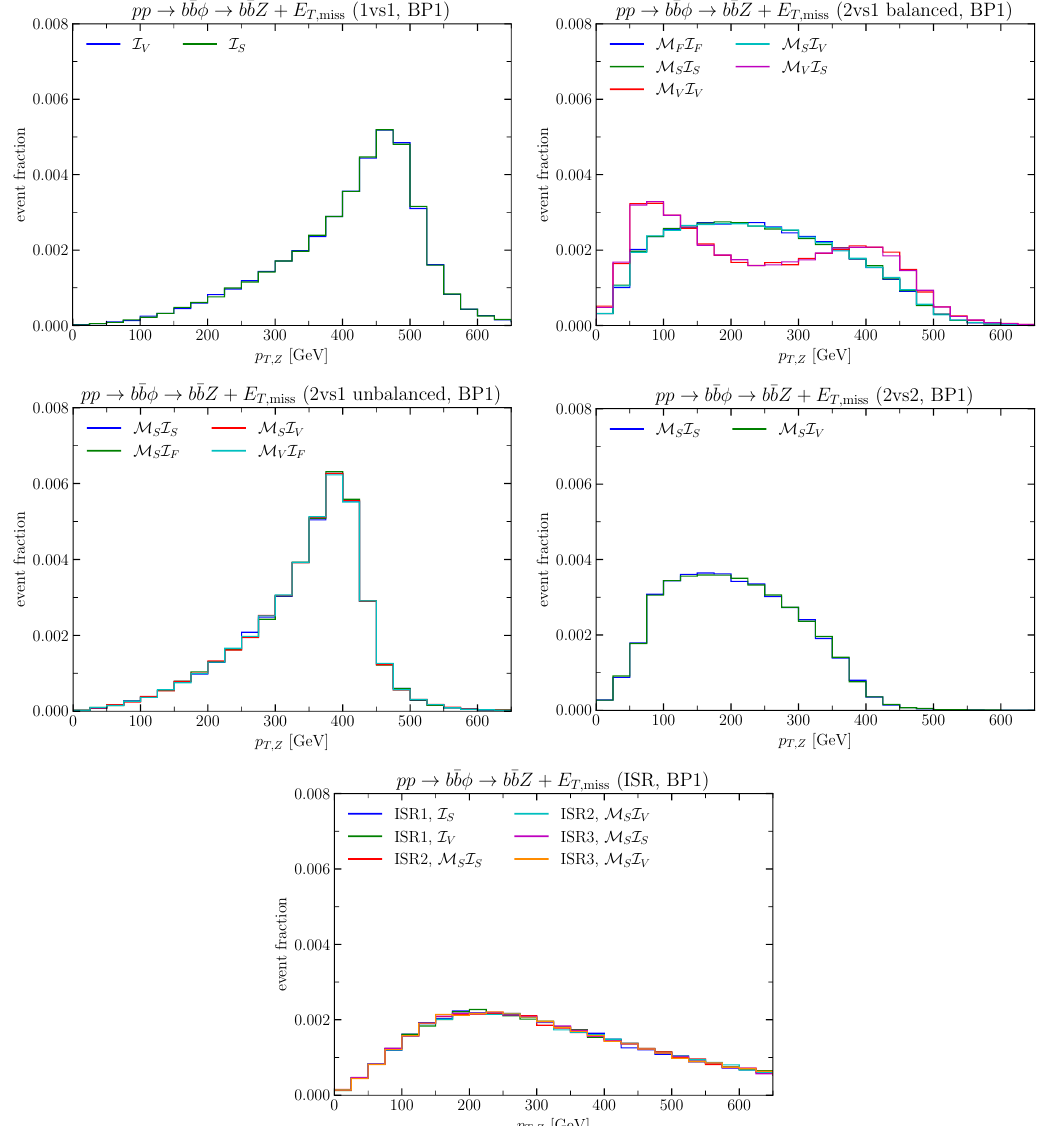
Figure 7. Mono- Z + E miss final state: transverse momentum distribution of the di-muon system T for BP1. The upper left panel displays the results for the 1vs1 balanced topology; the upper right panel for the 2vs1 balanced topology; the middle left panel for the 2vs1 unbalanced topology; the middle right panel for of the 2vs2 topology; and the lower panel for the ISR